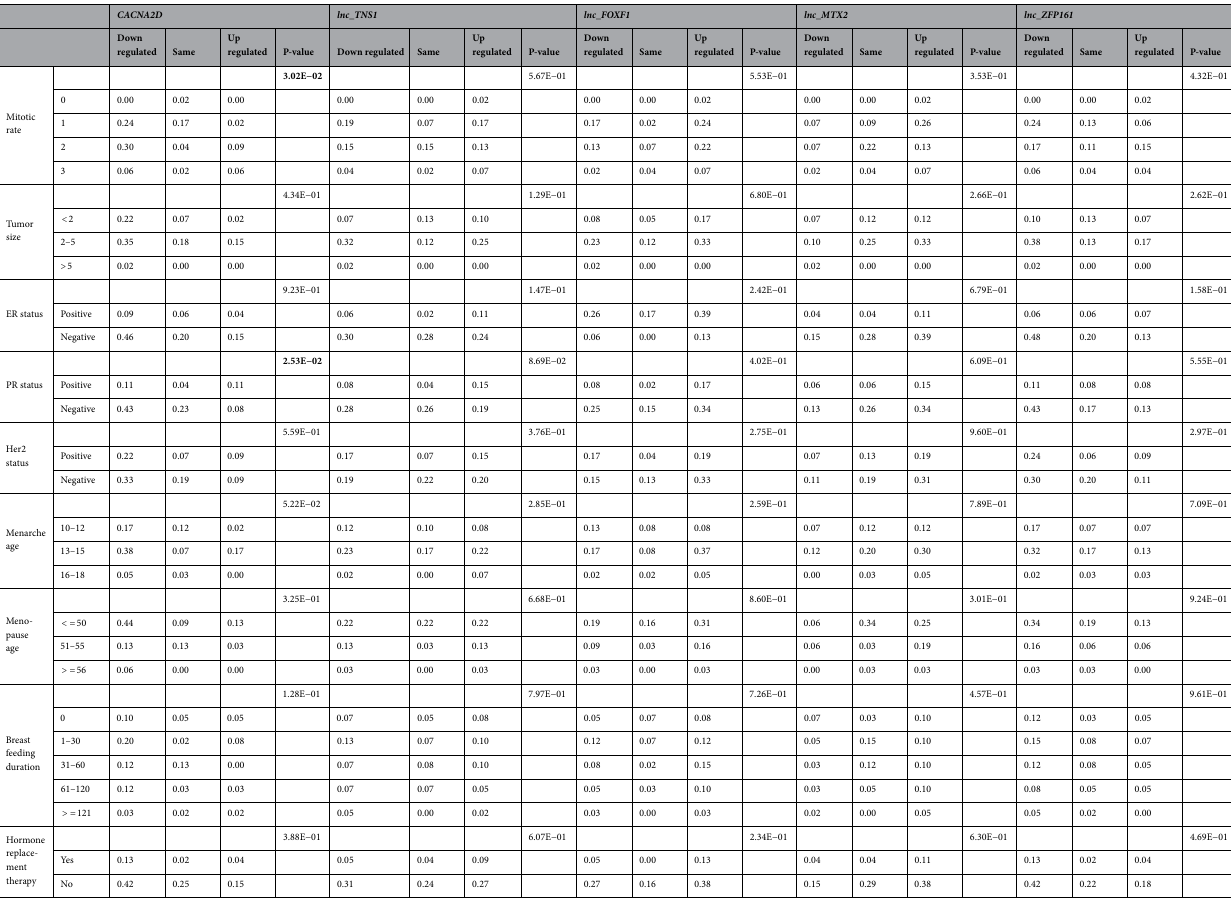
Table 3. Association between expression of oxytocin-related genes and clinical/demographic data.